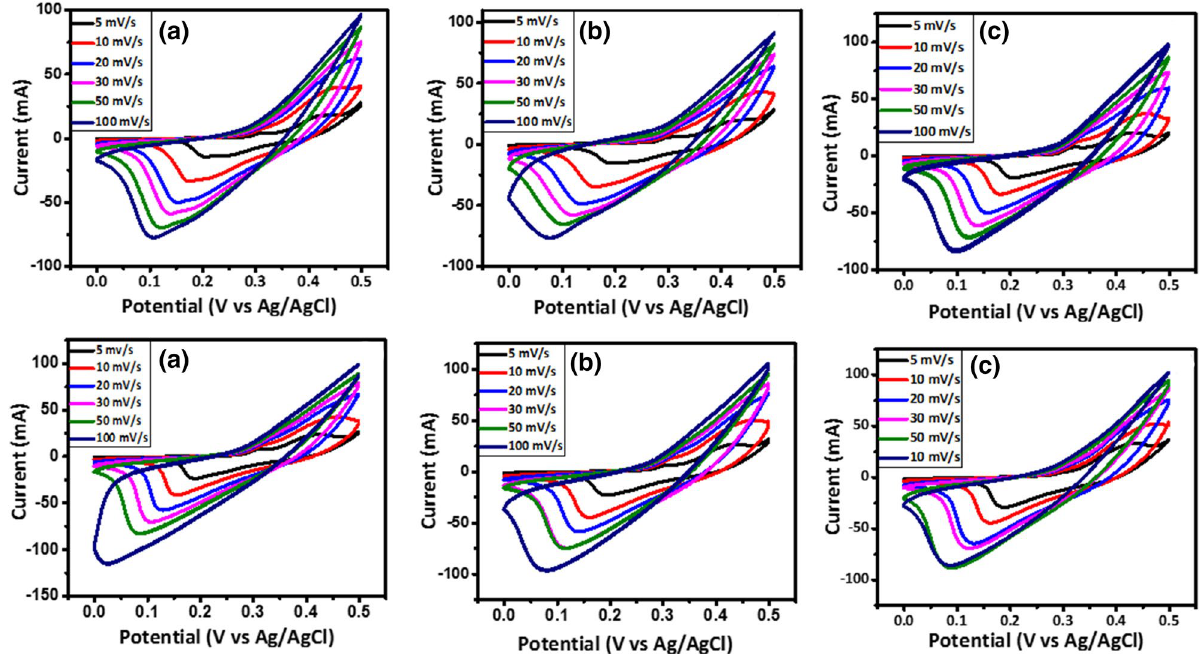
Figure 8. CV curves of the electrodes constructed from the prepared Ni 1−x Mn x Fe 2 O 4 nanoparticles where ( a ) x = 0, ( b ) x = 0.2, ( c ) x = 0.4, ( d ) x = 0.6, ( e ) x = 0.8, and ( f ) x = 1 at the scan rates of 5–100 mV/s.